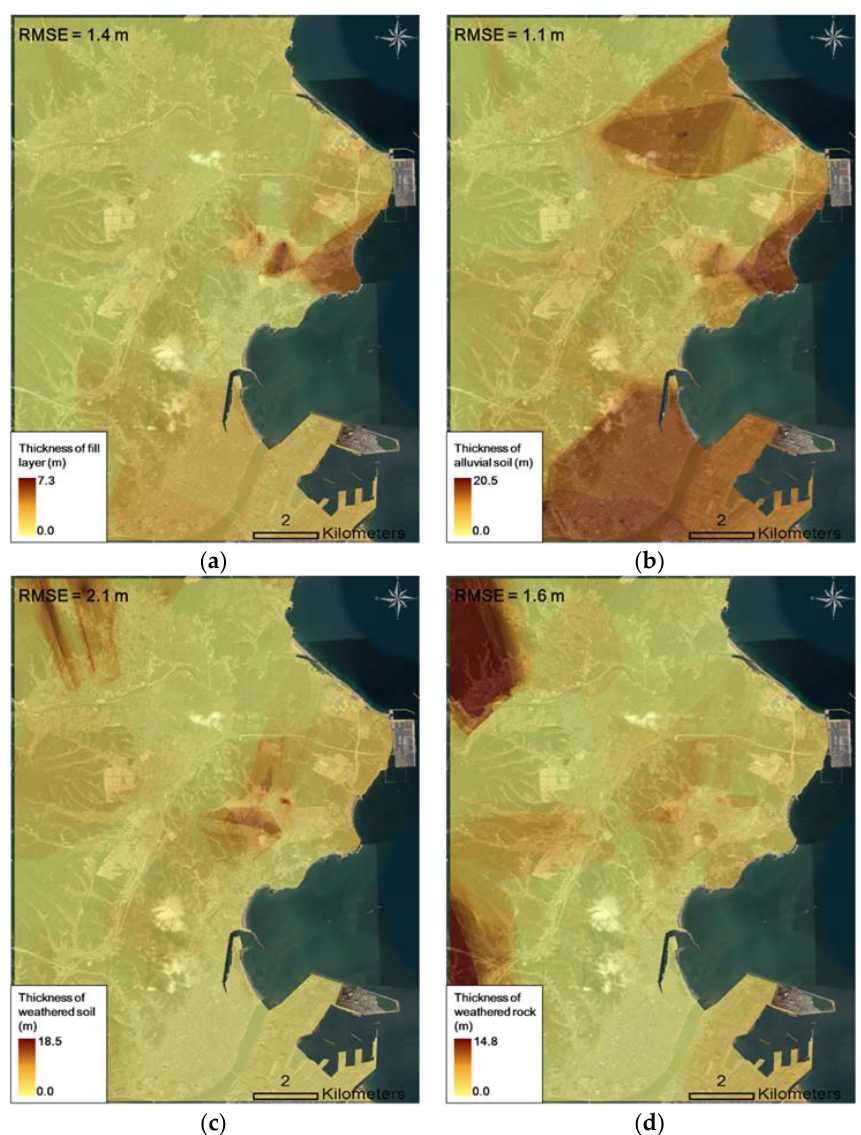
Figure 5. Geospatial grid information of representative geo-layers: ( a ) fill layer; ( b ) alluvial soil; ( c ) weathered soil; ( d ) weathered rock.